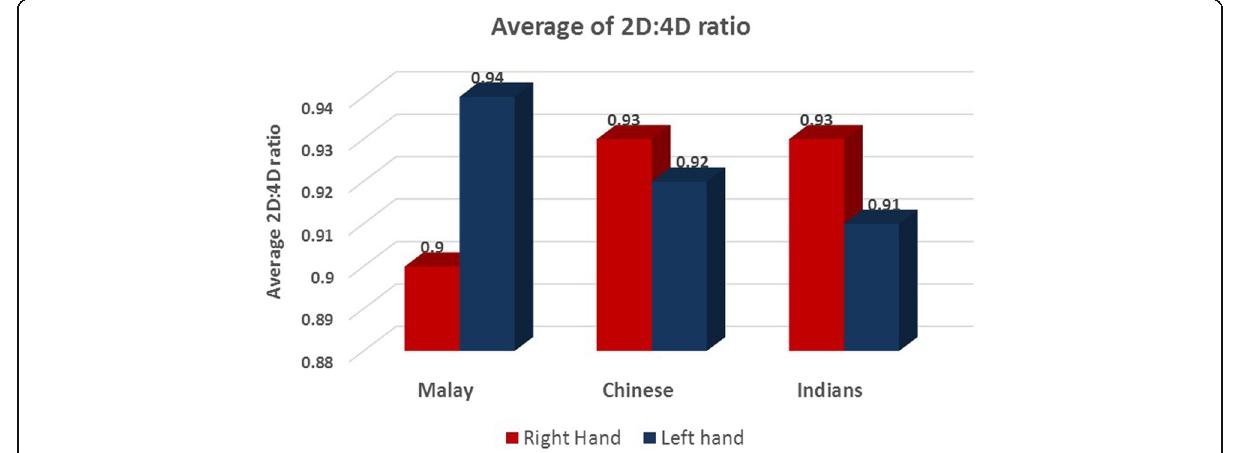
Fig. 5 Average of 2D:4D ratio in the right and left hands of participants based on